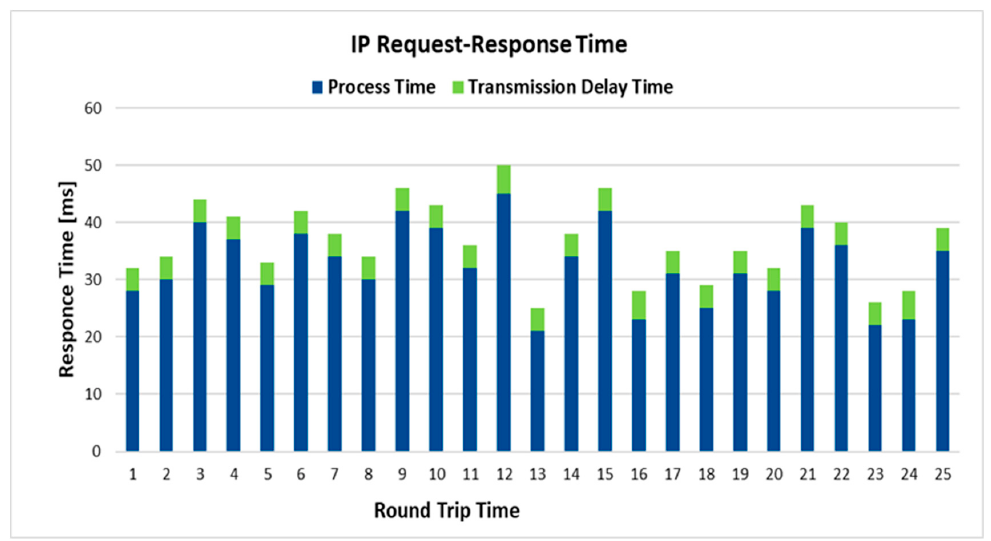
Figure 16. Round Trip Time of the IoT device registration.